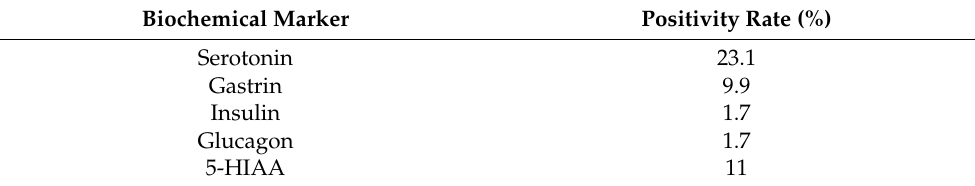
Table 3. Positivity rate for neuroendocrine biochemical markers.